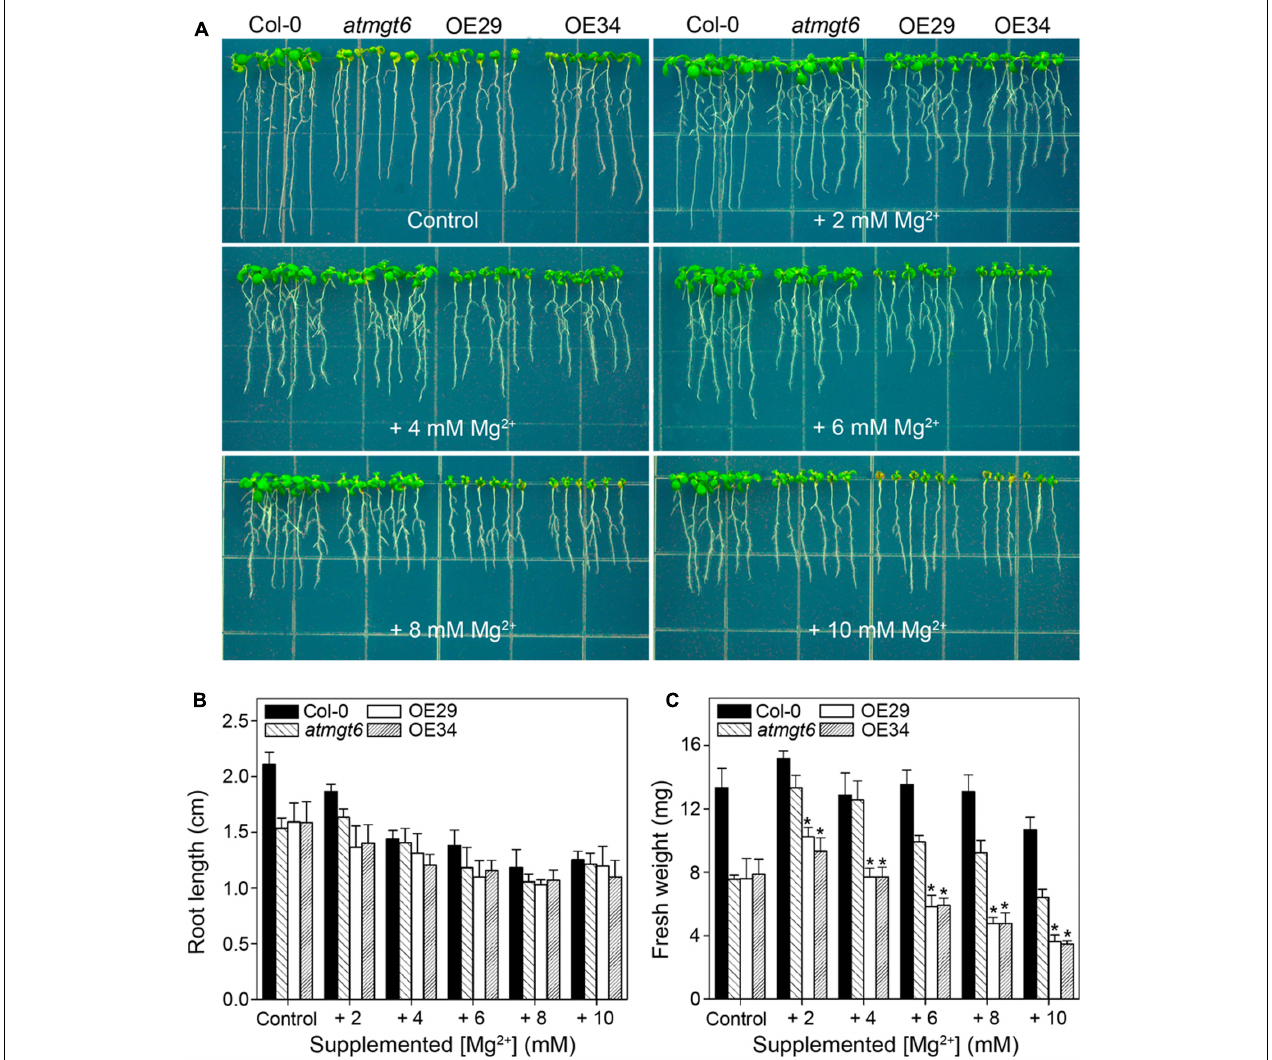
FIGURE 4 | Growth phenotype of atmgt6 and transgenic OsHKT2;4 -overexpression atmgt6 lines in high-Mg 2 + conditions. (A) The growth of Col-0, atmgt6 , OE29, and OE34 under the Mg 2 + -abundant conditions. After planted in half-strength MS (1/2 MS) medium for 3 days, Col-0, atmgt6 , OE29, and OE34 were transferred to one-sixth-strength MS (1/6 MS, referred to as “Control” in the figure) containing a basal 0.25 mM Mg 2 + and 1/6 MS medium supplemented with extra 2, 4, 6, 8, and 10 mM Mg 2 + . Plants were photographed after growing for another 7 days. Quantitative analyses of primary root length (B) and whole-plant fresh weight (C) of Col-0, atmgt6 , OE29, and OE34 under the Mg 2 + -abundant conditions described in (A) . Six independent 10-day-old seedlings of each genotype were gathered as one biological repeat for root length and fresh weight measurement. Data are represented as the mean ± SD, n = 3, in which n is the number of biological repeat. Asterisks indicate statistically significant differences compared with atmgt6 (Student’s t -test, ∗ P <